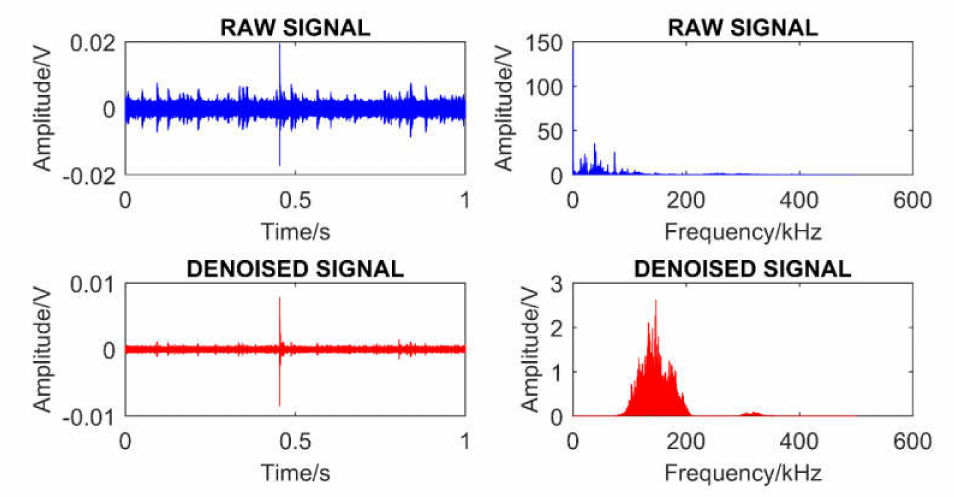
Figure 9. Di ff erences between the signals before and after filtering noise in both the time and frequency